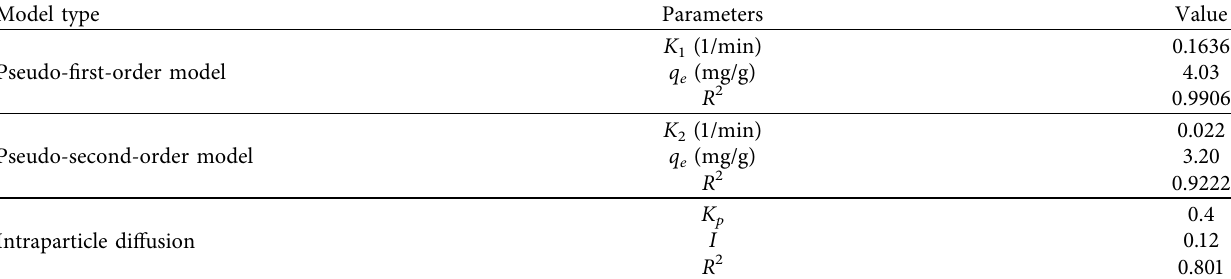
Table 7: Kinetic parameters for the adsorption of ATN onto